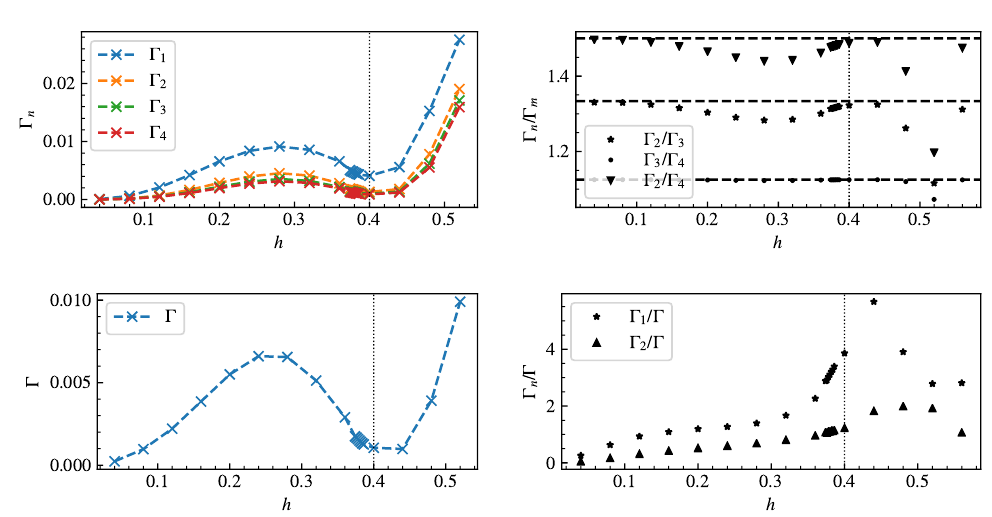
Figure B.3: Left panels: Entropy growth rates Γ (top) and magnetisation relaxation n rate Γ (bottom) in units J = 1 for longitudinal quenches in the quantum Ising spin chain starting from g = 2.0 as a function of the longitudinal coupling. Right: Ratios Γ / Γ / Γ (bottom). The dashed lines represent the universal ratios (4.4) (top) and Γ n m n that are restored in the limit h → 0. The vertical line is drawn at the value h where crit the second quasi-particle appears in the post-quench spectrum.